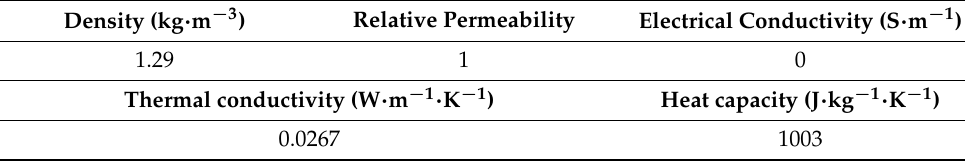
Table 4. The material properties of